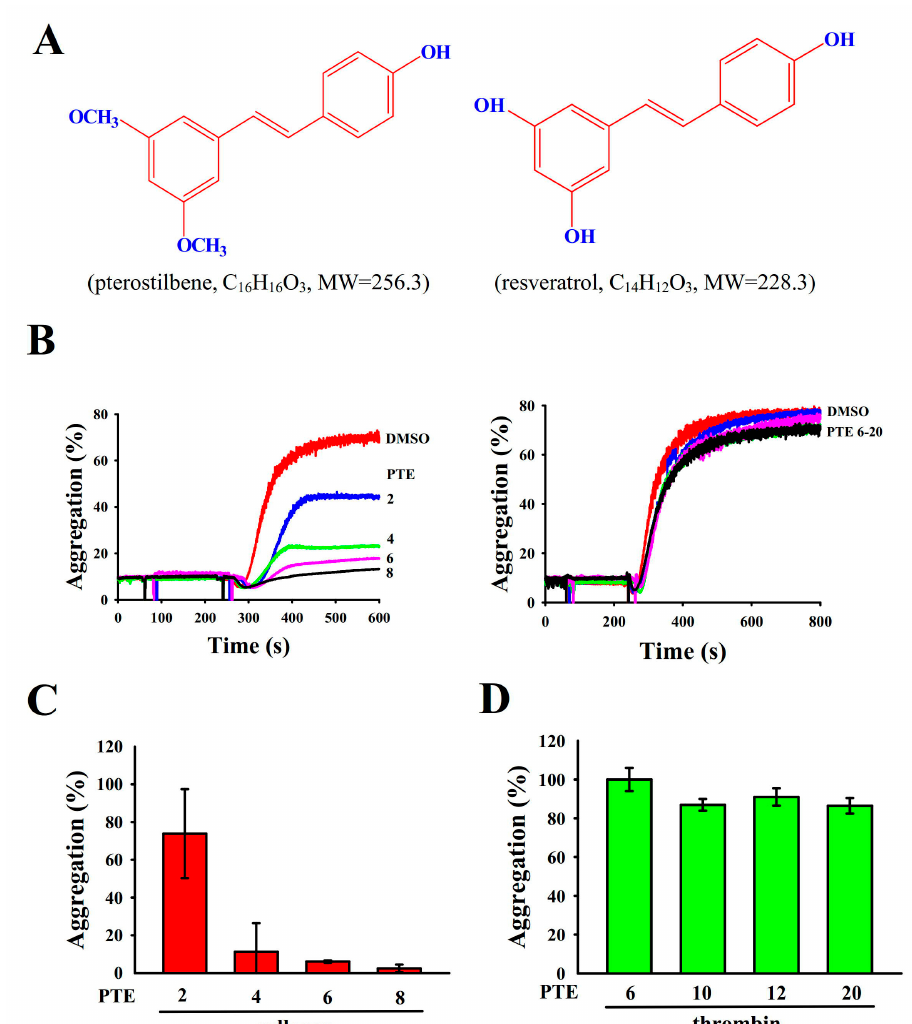
Figure 1. Inhibitory profiles of the effects of pterostilbene (PTE) on platelet aggregation stimulation by collagen and thrombin. ( A ) Chemical structures of PTE (C 16 H 16 O 3 ) and resveratrol (C 14 H 12 O 3 ). ( B ) Washed human platelets (3.6 × 10 8 cells/mL) were preincubated with a solvent control (0.1% DMSO) or PTE (2–20 μ M) and subsequently treated with either collagen (1 μ g/mL) or thrombin (0.01 U/mL) to stimulate platelet aggregation. ( C , D ) Concentration–response histograms of PTE demonstrating its inhibitory activity for platelet aggregation stimulated by collagen (%). Data are presented as the mean ± standard deviation ( n = 4).